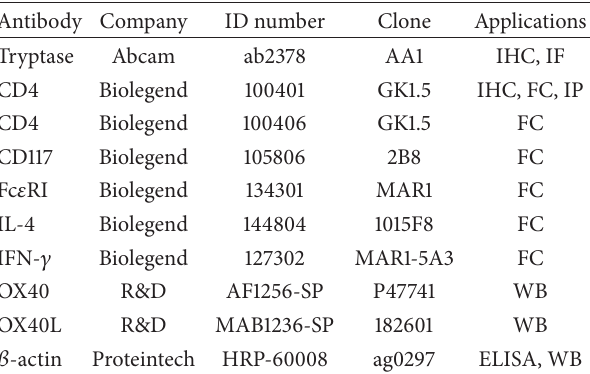
Table 1: Antibody